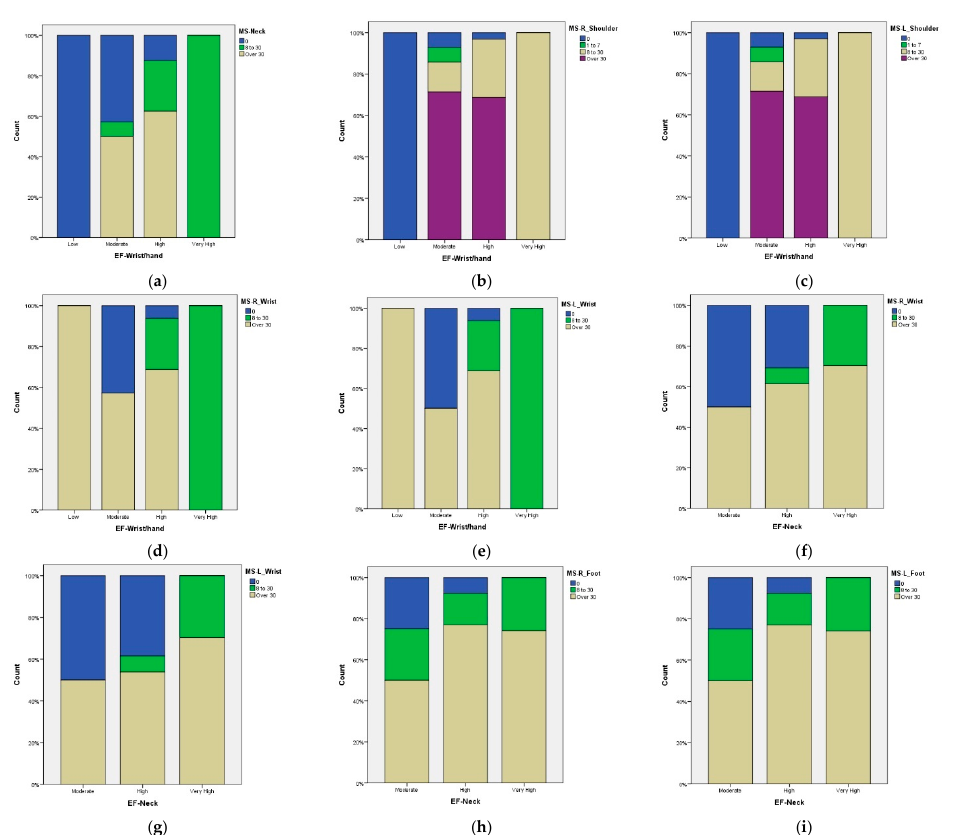
Figure 2. Crossover between musculoskeletal symptoms by QEC method exposure level. Exposure factor—wrist/hand: ( a ) neck, ( b ) right shoulder, ( c ) left shoulder, ( d ) right wrist, ( e ) left wrist, and Exposure factor—neck: ( f ) right wrist, ( g ) left wrist, ( h ) right foot, ( i ) left foot.